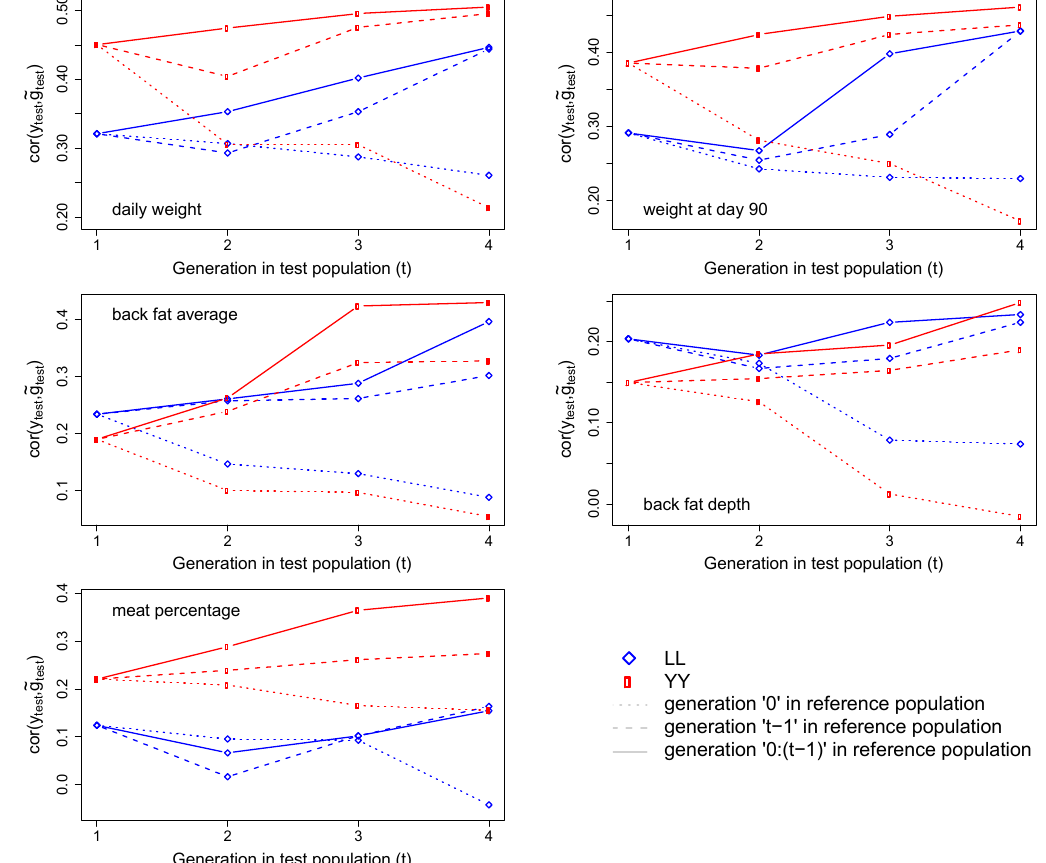
Figure 3. Prediction accuracies ( 𝑐𝑜𝑟(cid:3550) (𝒚 (cid:3047)(cid:3032)(cid:3046)(cid:3047) ,𝒈(cid:3557) (cid:3047)(cid:3032)(cid:3046)(cid:3047) ) , the correlation between real phenotypes in the test population, 𝒚 (cid:3047)(cid:3032)(cid:3046)(cid:3047) , and predicted breeding values, 𝒈(cid:3557) (cid:3047)(cid:3032)(cid:3046)(cid:3047) ) by breed (Landrace (LL) and Yorkshire (YY)) and generations (one to four, the last one combining generations four to six). Results are presented for the di ff erent generations considered as the reference population to perform genomic prediction, to predict a test generation (t).